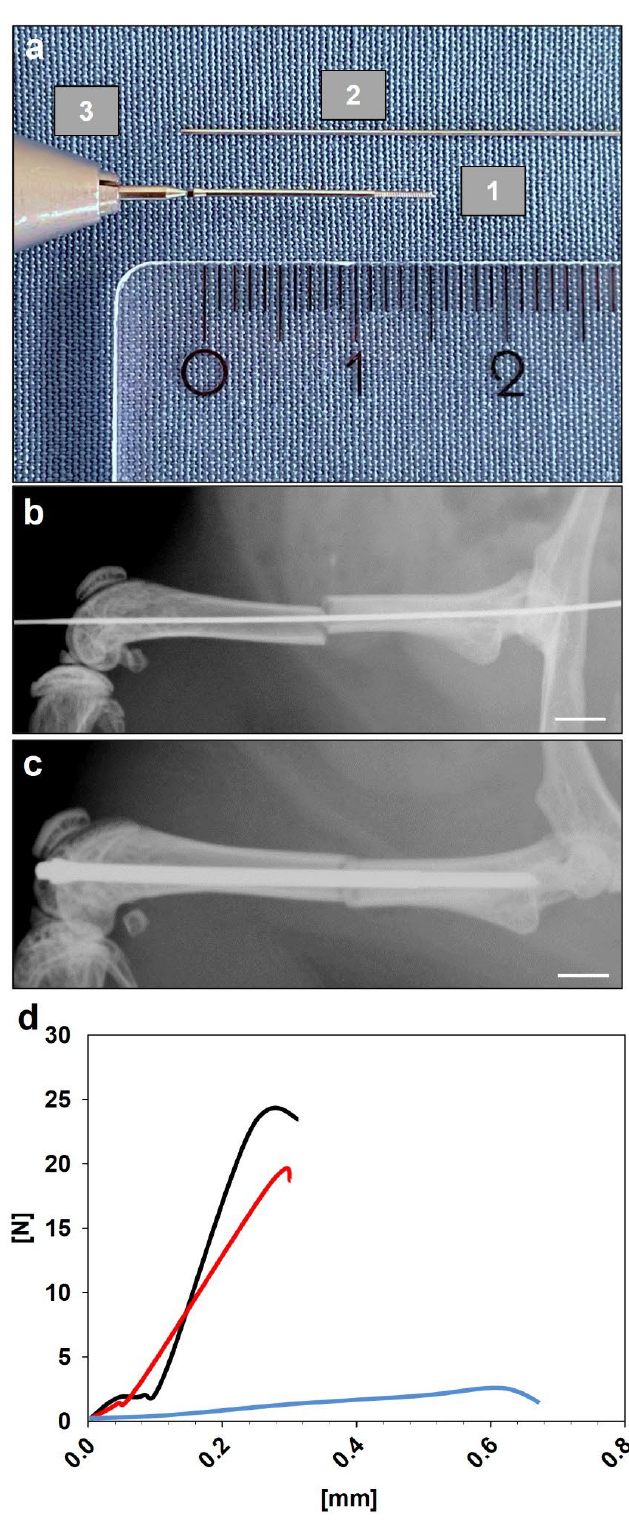
Figure 1. ( a ) Illustration of the intramedullary MouseScrew (1), the tungsten guide-wire (2) and the screw holder (3) used in the present fracture model. Scale bar: 2 mm. ( b ) Fractured femora with inserted tungsten guidewire to guide the MouseScrew during insertion. Scale bar: 2 mm. ( c ) Fractured femora after intramedullary stabilization with the MouseScrew. Scale bar: 2 mm. ( d ) Representative load displacement curves of an intact femur (black), 1 week after fracture (blue) and 5 weeks after fracture (red) in young adult